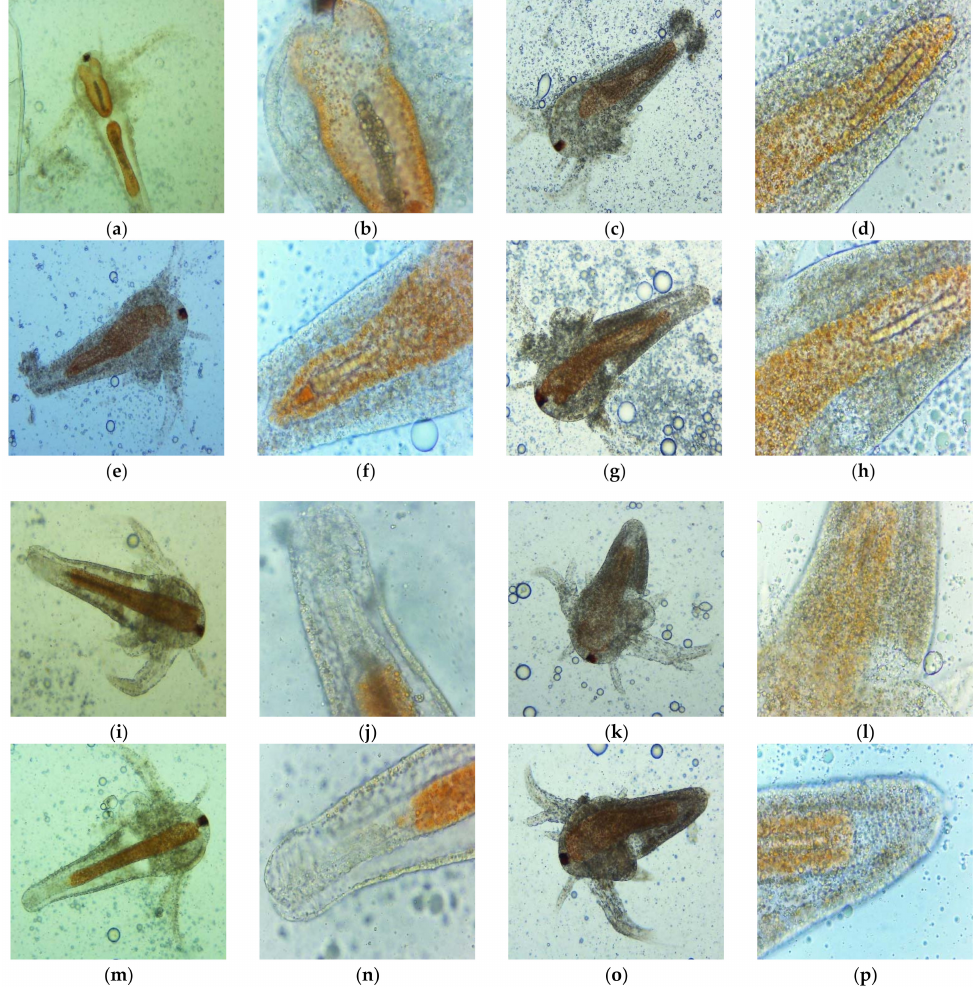
Figure 7. Morphological changes induced by UBO ( a , b , e , f , i , j , m , n ) and CNO ( c , d , g , h , k , l , o , p ) with different dilutions: 1:1 ( a – d ), 1:2 ( e – h ), 1:3 ( i – l ), 1:4 ( m – p ) on A. salina larvae after 6 h exposure, in microscopical images at different magnifications: 100 × ( a , c , e , g , i , k , m , o ) and 400 × ( b , d , f , h , j , l , n , p